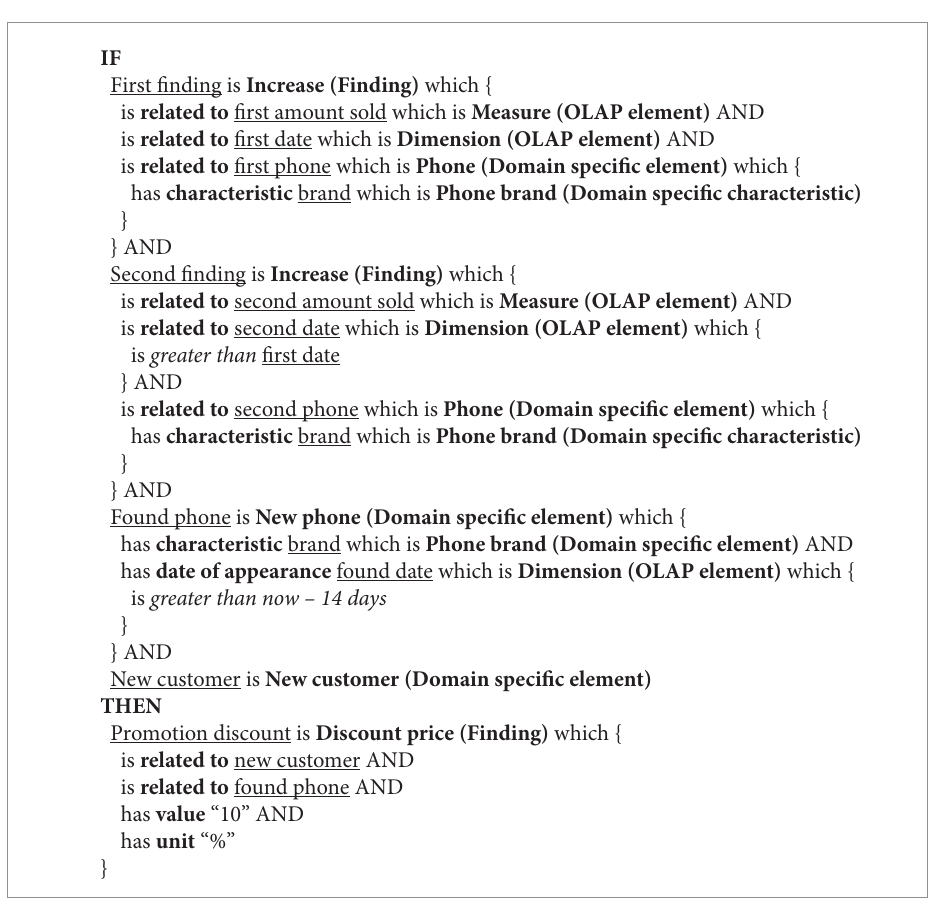
Fig. 5. Example of a rule, developed by using